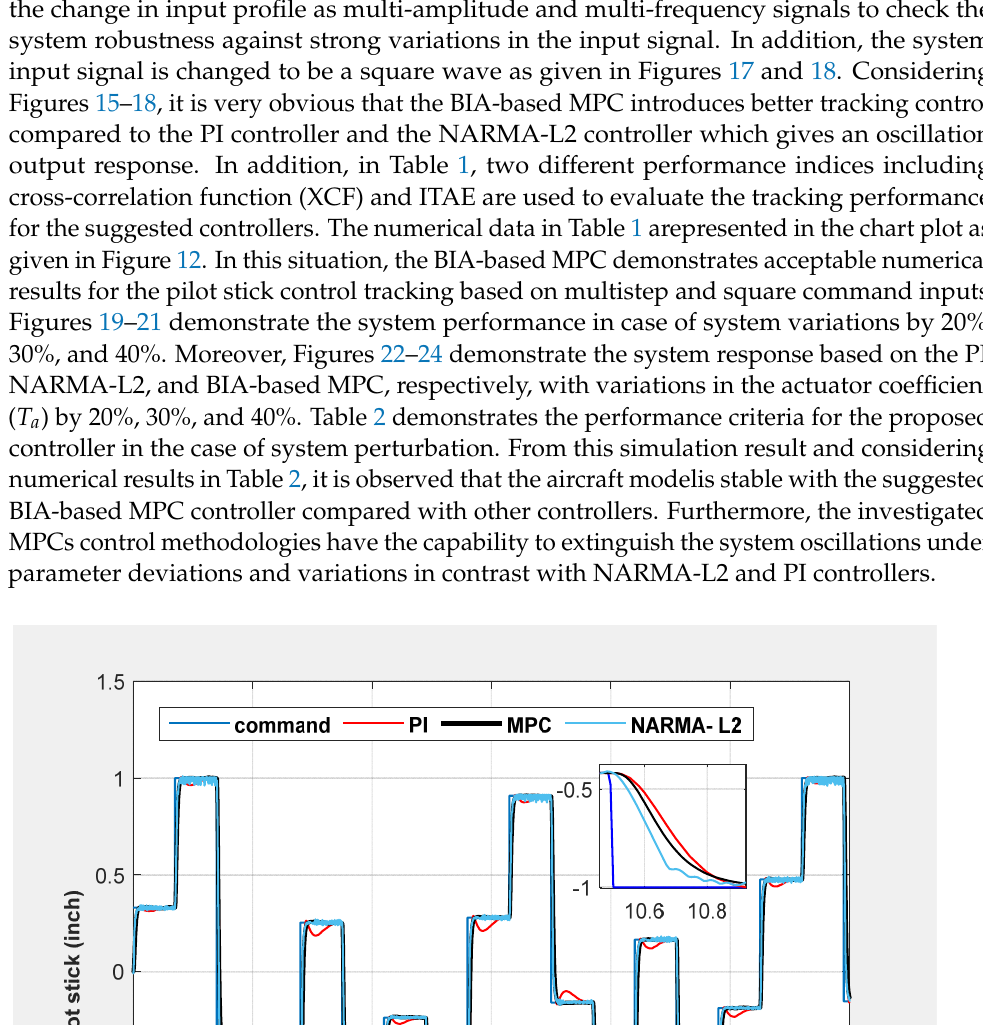
Figure 16. Pilot stick multistep response with corresponding error.